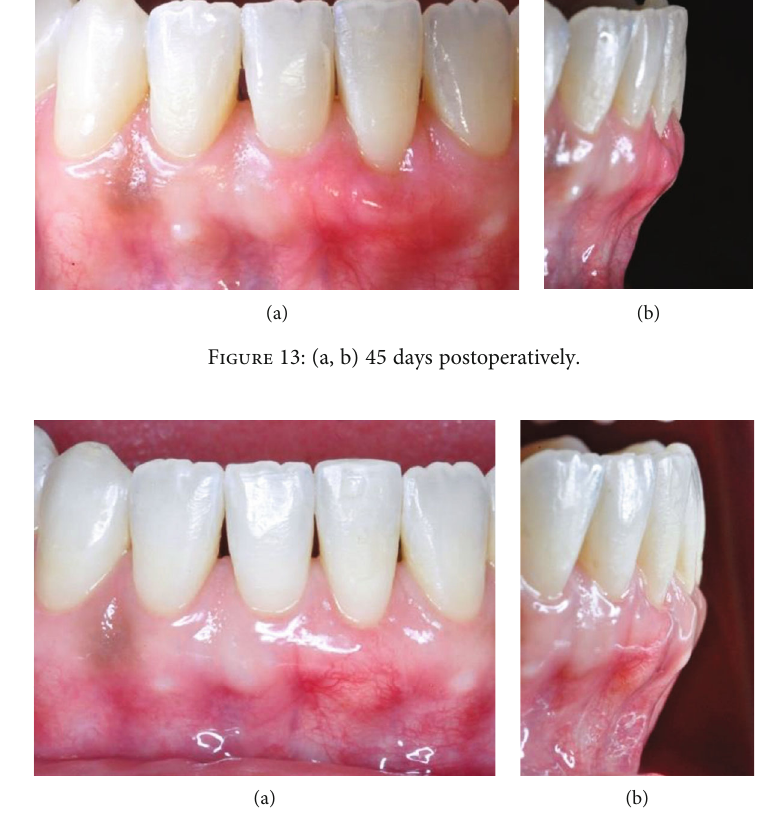
Figure 14: (a, b) 60 days